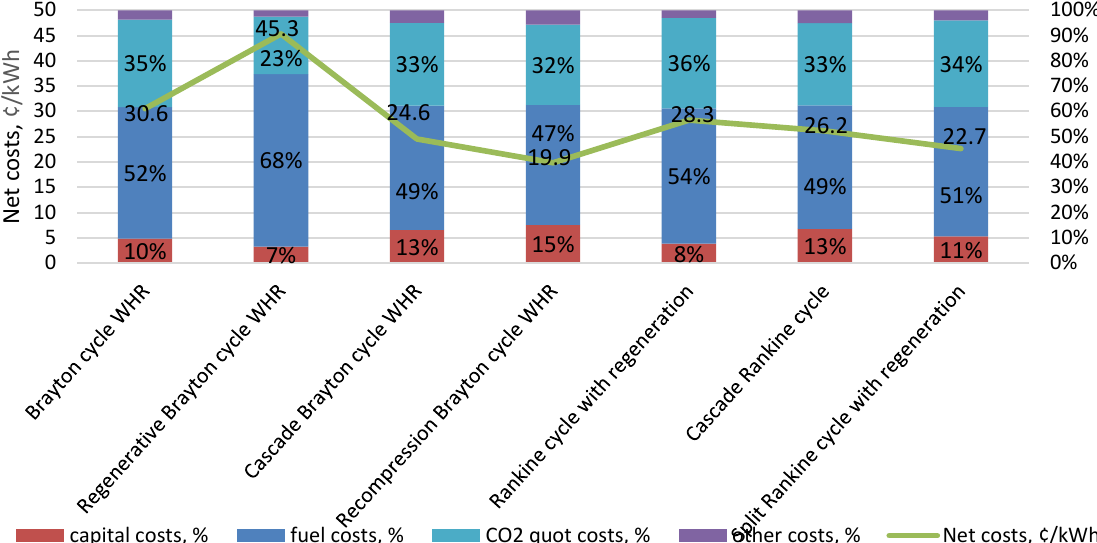
Figure 33. Cost of electric power generated with regeneration CO 2 power cycles at the cost of CO 2 emission quotas of 50 $/ton for small-capacity distributed power.